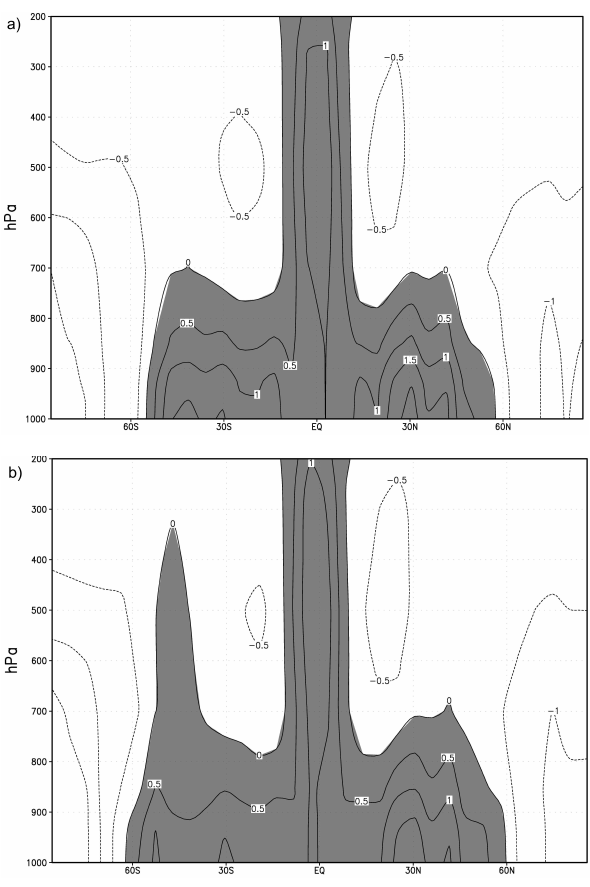
Fig. 3. Zonally averaged mean heating rates (in K/day) for the 100 (a) and 1000 (b) ppm CO 2 concentration runs.